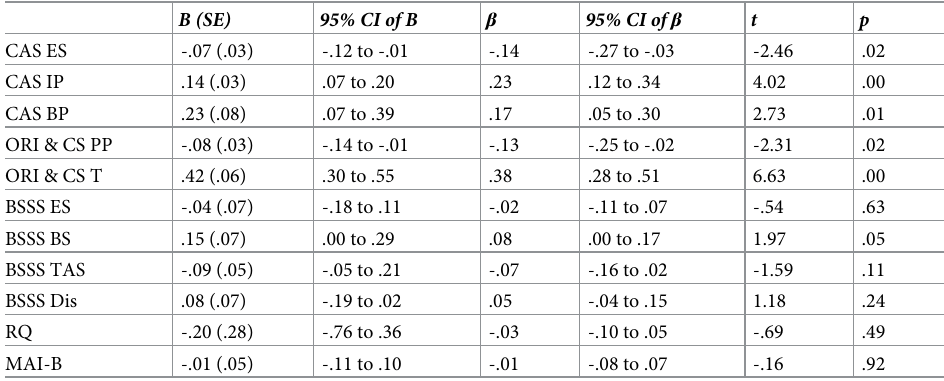
Table 3. Multiple linear regression using CAS, ORI & CS, BSSS, RQ and MAI-B to predict